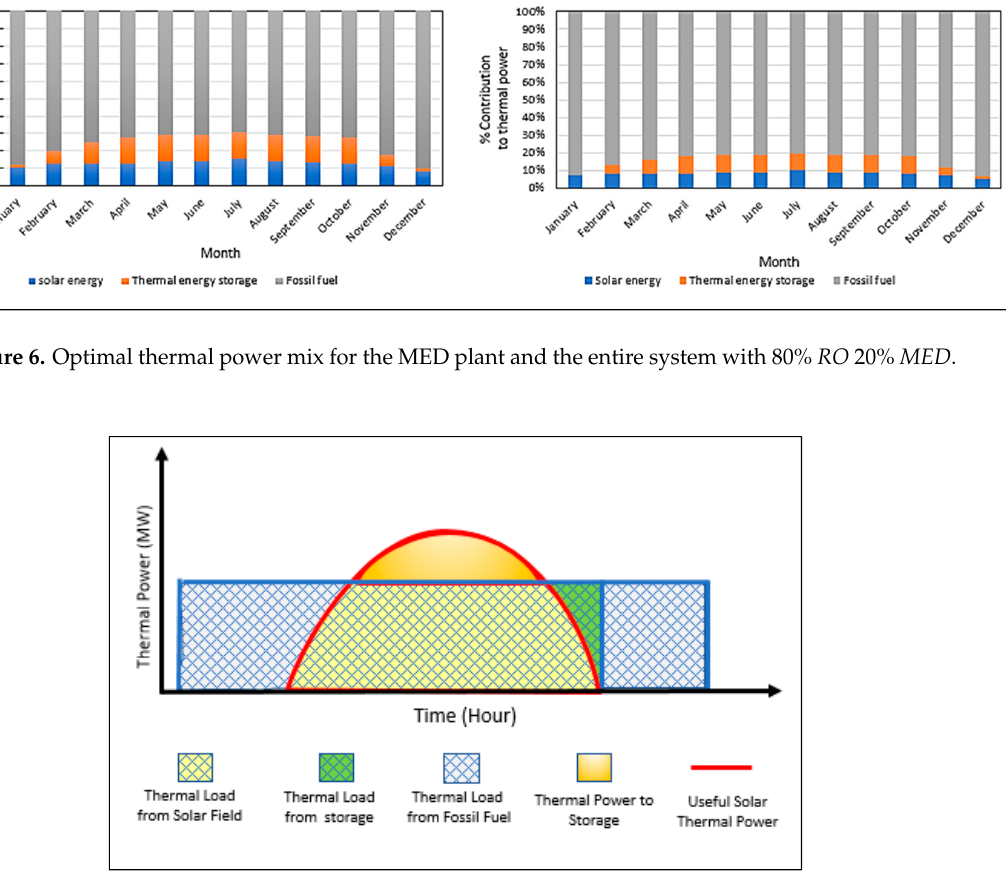
Figure 7. Optimal operation for MED during January, February, November and December. Processes 2018 , 6 , x FOR PEER REVIEW